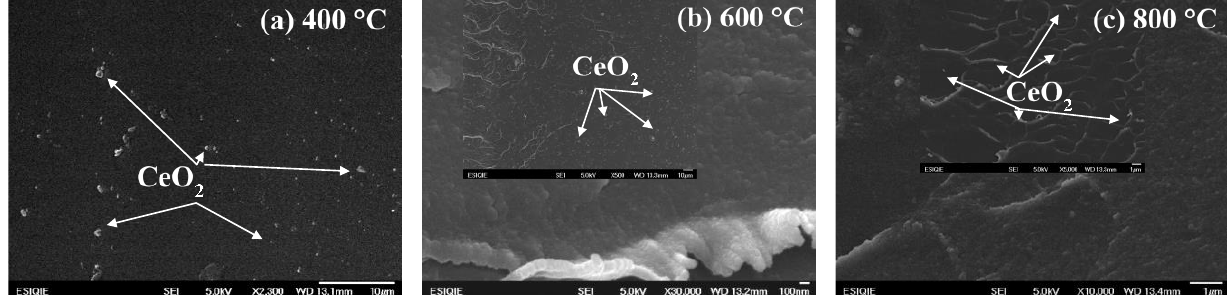
nanoparticles 2